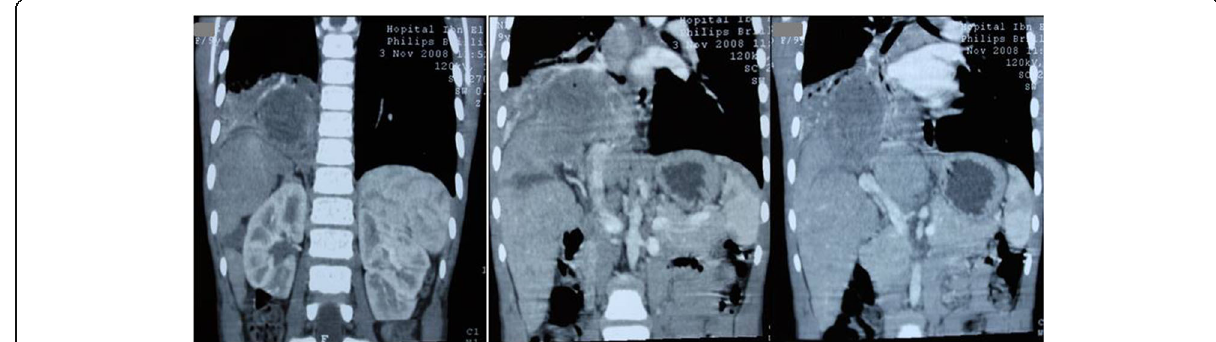
Fig. 3 CT scan revealing a hydatid cyst of the hepatic dome complicated by intrathoracic rupture into the bronchial